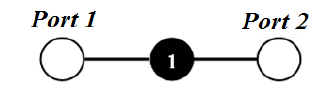
FIGURE 4. Schematic of the resonator 1 in step one.